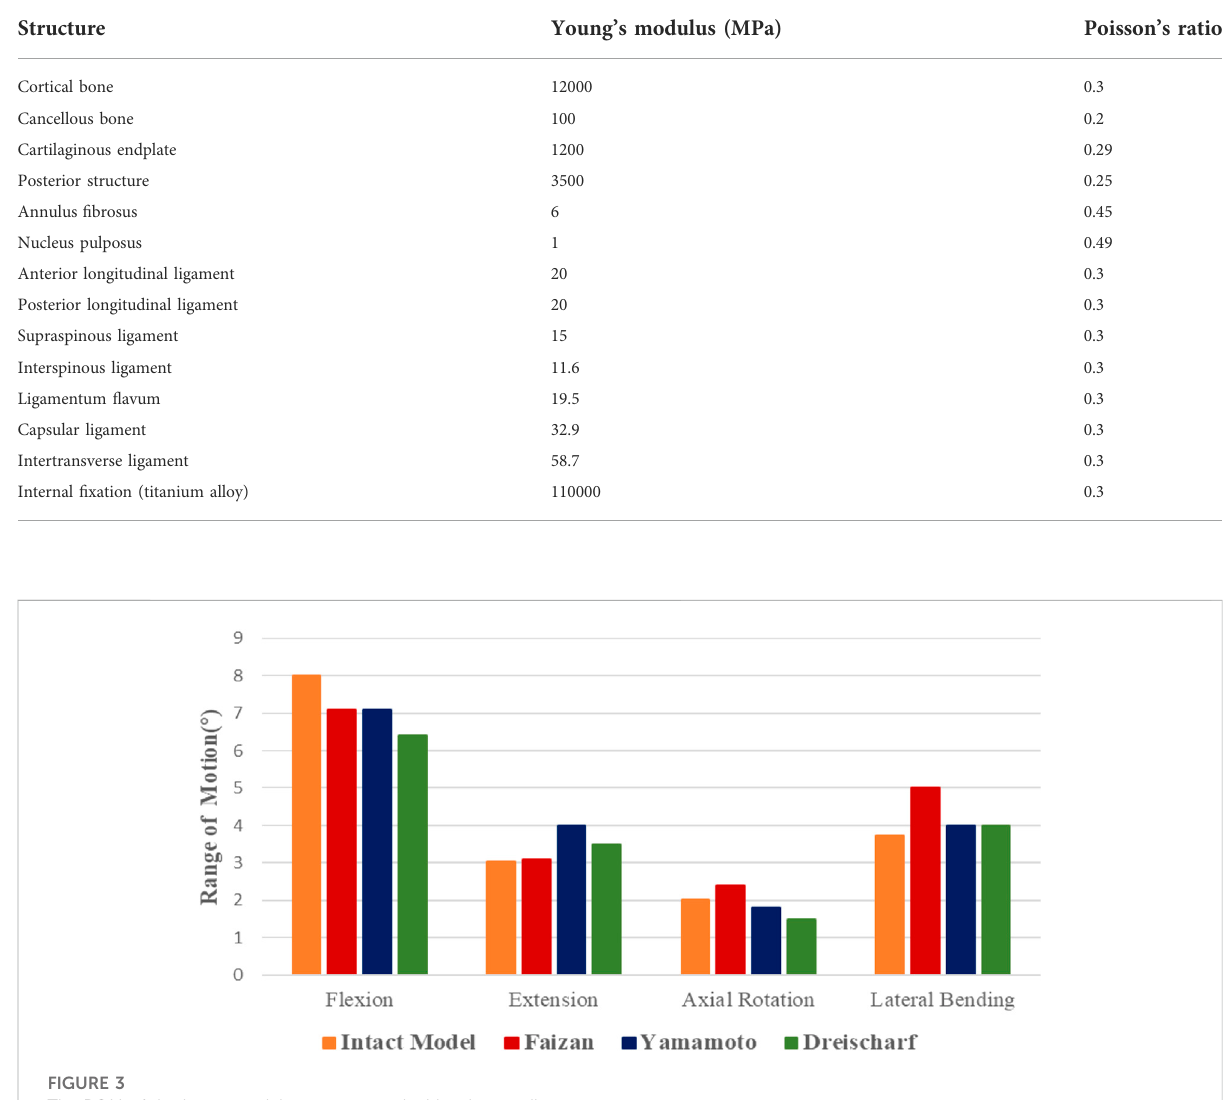
TABLE 1 Material properties of fi nite element models (Elmasry et al., 2018; Li et al., 2022a).